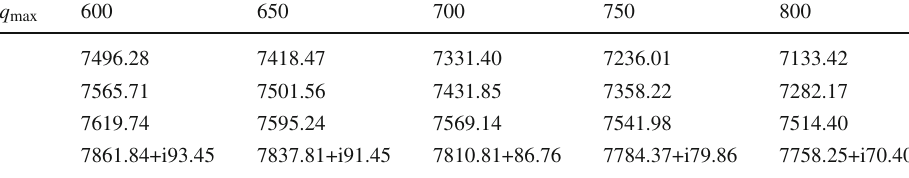
vector–baryon (1/2) (MS) states (all units are in